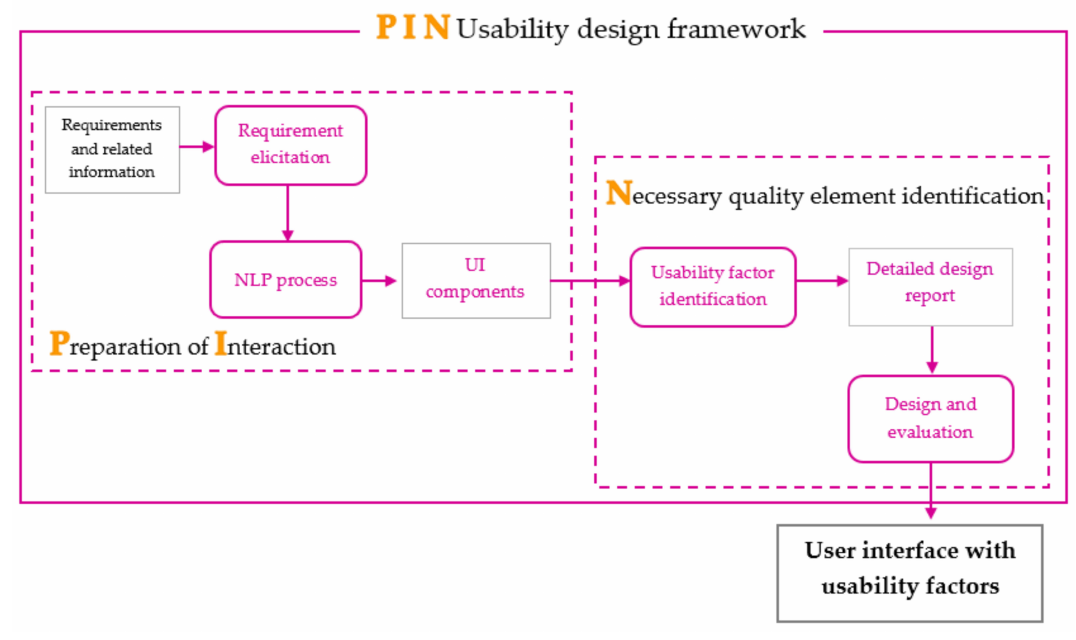
Figure 2. PIN usability design framework’s